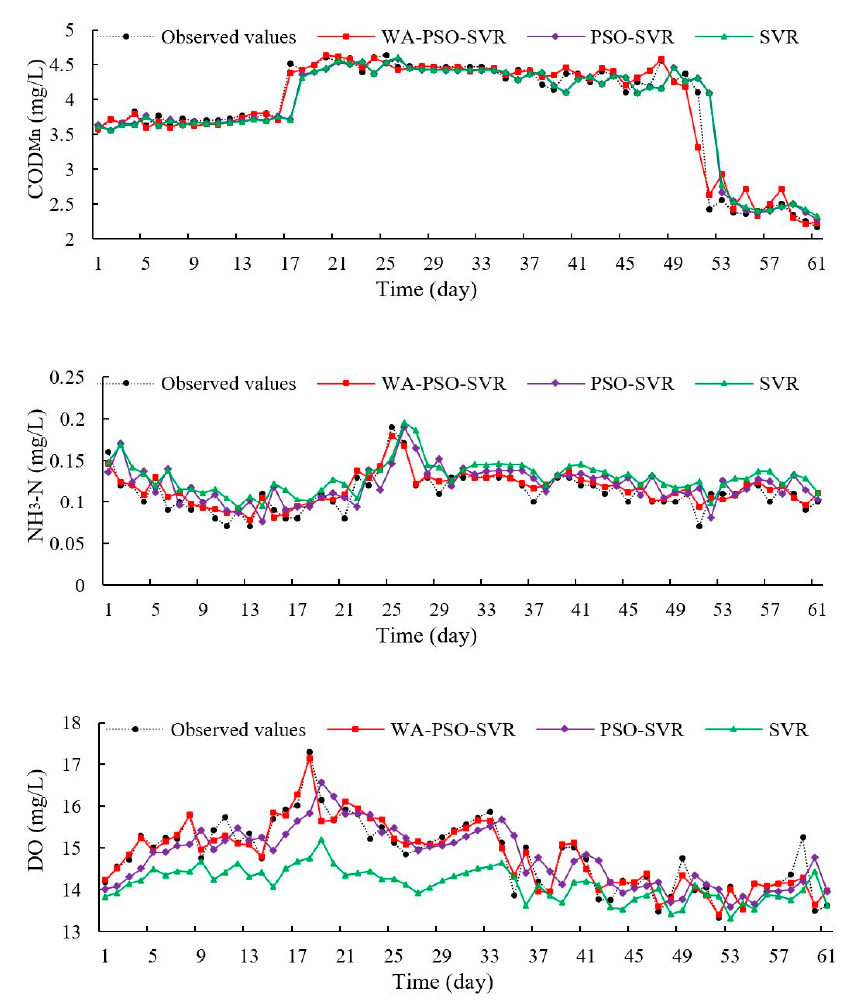
Figure 5. Observed versus predicted values of daily data in the testing phase.